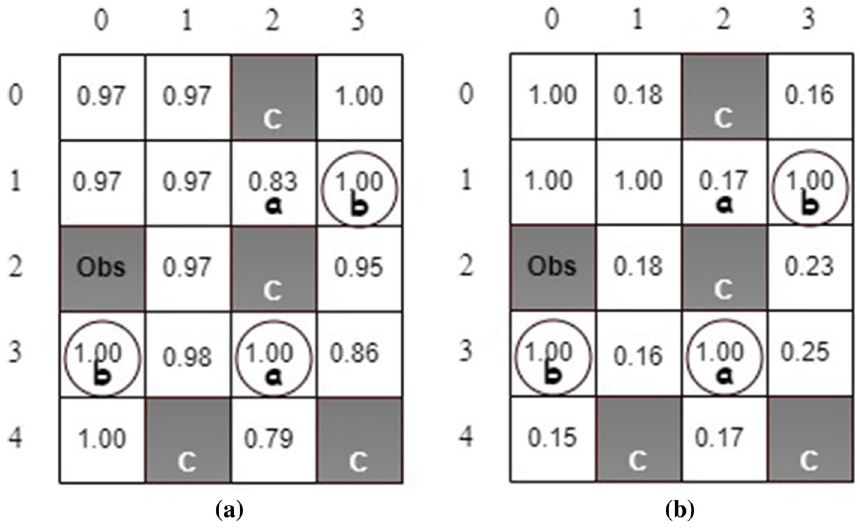
Figure 9. The estimated ( a ) state values and ( b ) state safety values for stochastic actions.